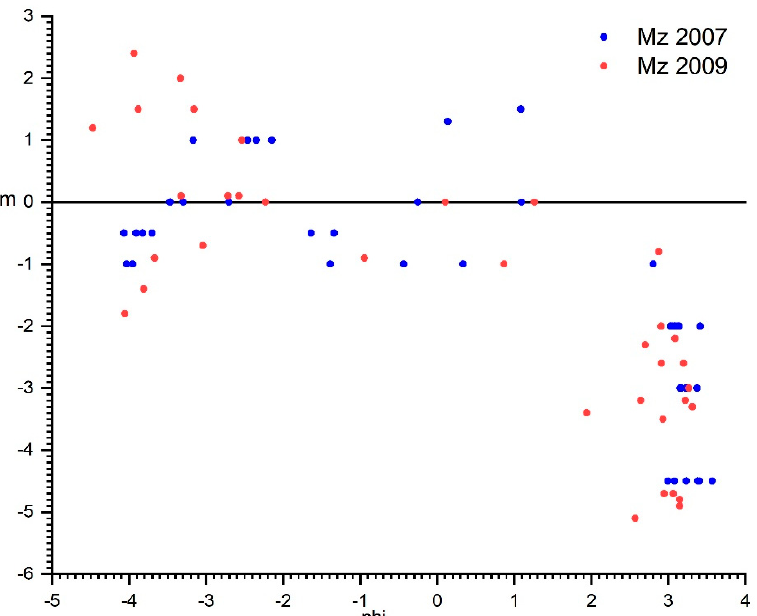
Figure 12. Mean size (phi) vs. Depth (m) for the sediments at Cavo in June 2007 and May 2009.